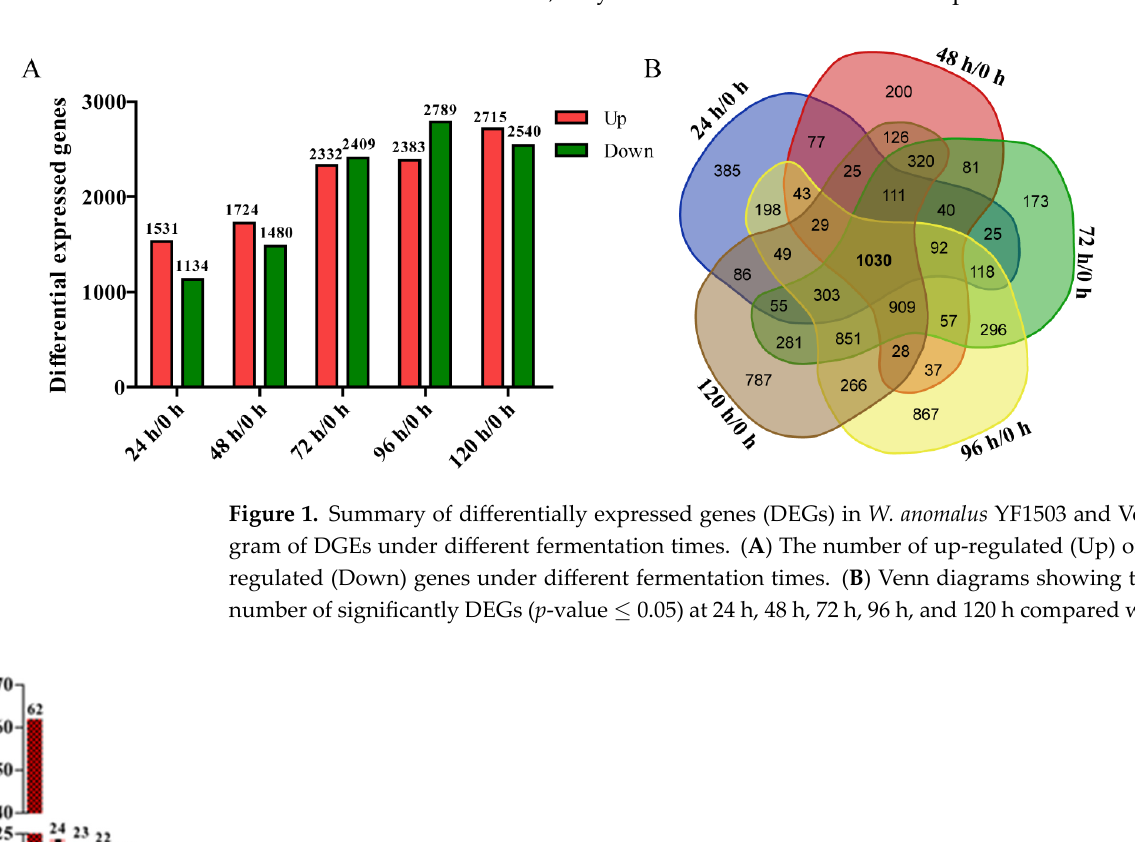
Figure 1. Summary of differentially expressed genes (DEGs) in W. anomalus YF1503 and Venn dia- gram of DGEs under different fermentation times. ( A ) The number of up-regulated (Up) or down- regulated (Down) genes under different fermentation times. ( B ) Venn diagrams showing the total number of significantly DEGs ( p -value ≤ 0.05) at 24 h, 48 h, 72 h, 96 h, and 120 h compared with 0 h.